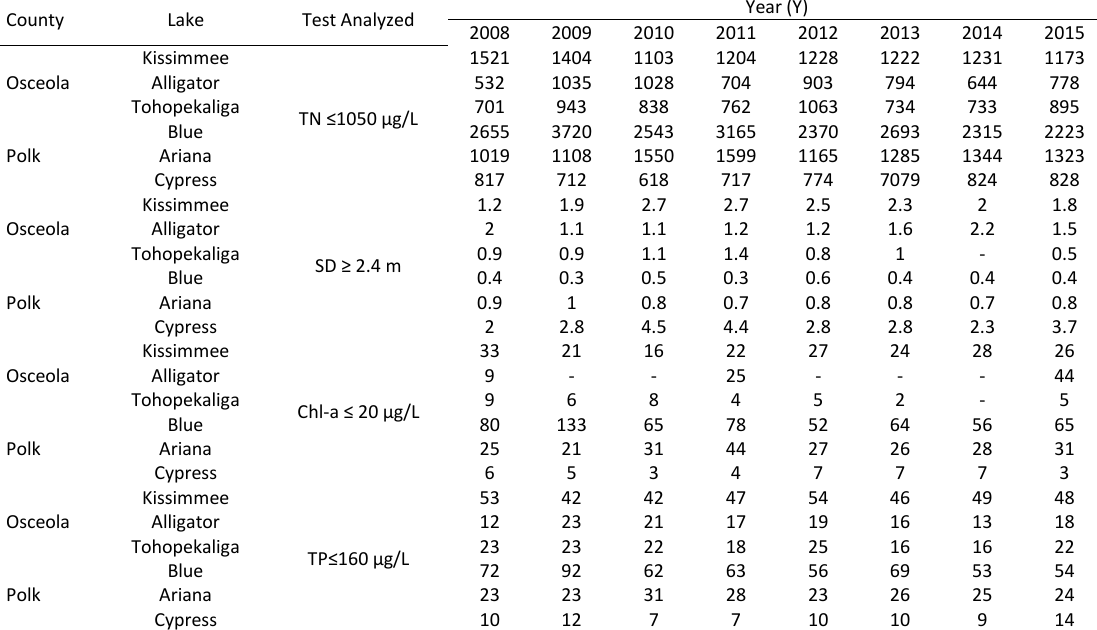
Table 1: Osceola and Polka Counties TN, TP, Chl-a, and SD Average Result for each year for each County